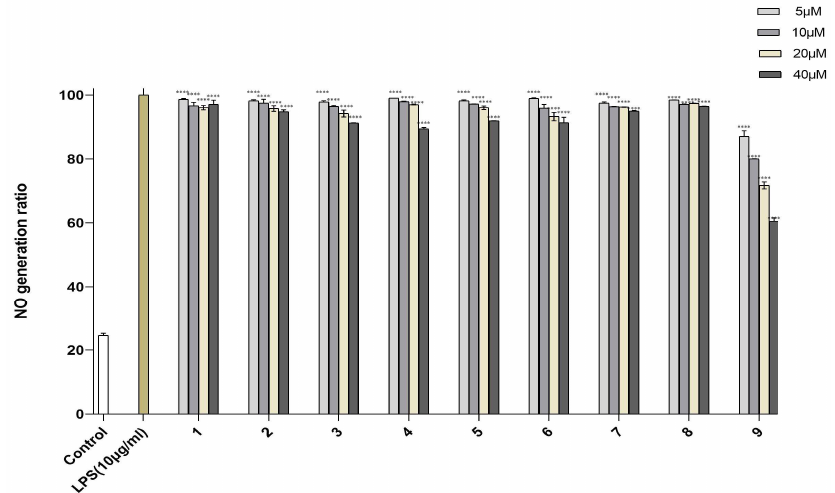
Figure 5. NO production in RAW246.7 cells treated with compounds 1 – 9 . Control was used for blank control, LPS-induced NO production was used for positive control and represented at 100%. Data